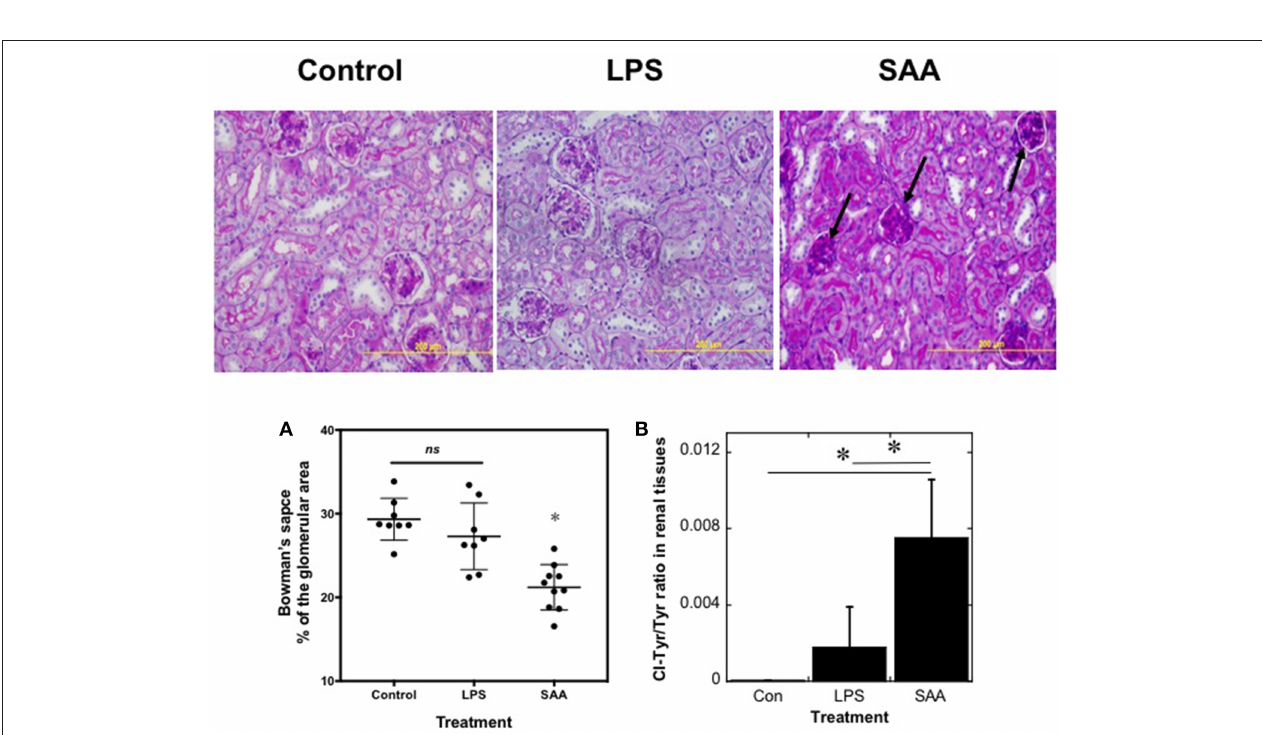
FIGURE 5 | SAA promotes kidney inflammation in ApoE − / − mice. ApoE − / − mice were administered SAA, LPS or sterile PBS for 2 weeks (as described in Study 1). After a further 2 weeks mice were sacrificed and kidney sections from control, LPS- and SAA-treated mice were stained with PAS. Data represent at least 3 different fields within each kidney section obtained from n = 8 (control or LPS) or 10 (SAA) animals. Arrows highlight condensed glomeruli in renal samples from SAA-treated mice. Magnification x 200, scale bar = 200 µ m. The change in Bowman’s space (A) expressed as a percentage of the corresponding total glomerular area was calculated as defined in the Methods. Each point represents mean data from glomeruli present in a field of view (at least 3 fields of view; FOV) obtained at 200x magnification as assessed with Image-pro Plus (V6). Data represent mean ± SD ; n = 8 (Control) or 8 (LPS-) and 10 SAA-treated mice. * Different to vehicle- or LPS-treated mice in the absence of SAA; P < 0.05; ns , not significant. Renal homogenates were assayed simultaneously for 3-chlorotyrosine and total tyrosine content (B) . Quantitative mass data represent mean ± SD ; n = 5 (Control) or 4 (LPS- and SAA-treated) mice. * Different to vehicle- or LPS-treated mice in the absence of SAA; P <